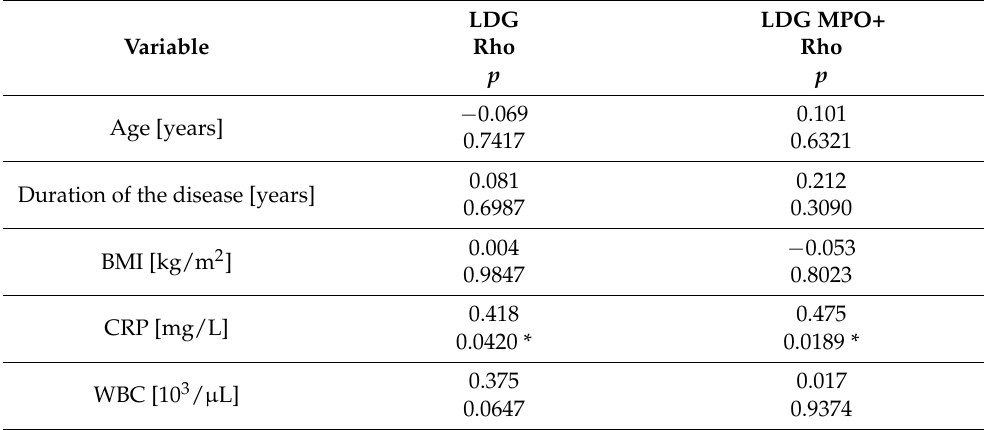
Table 4. Correlation between LDG and selected demographic-clinical and inflammatory parameters in the study group